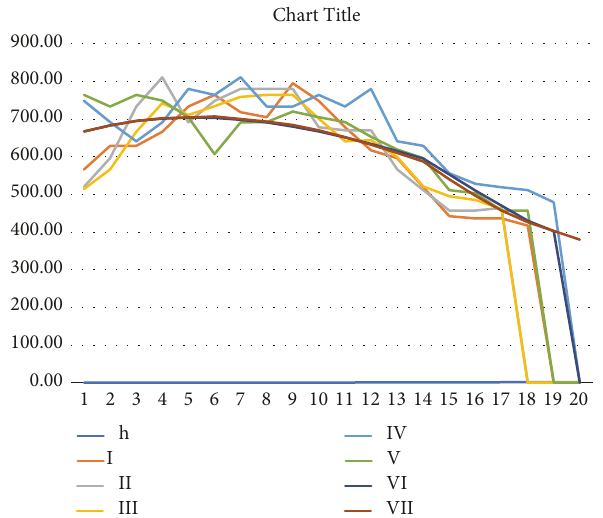
Figure 7: Hardness distribution along the thickness of the hardened layer. 1-3: actual distribution of hardness of samples of one batch (3 samples); 4: probabilistic curve of the actual hardness distribution (for 14 samples with a probability of 90%); 5: distribution according to the